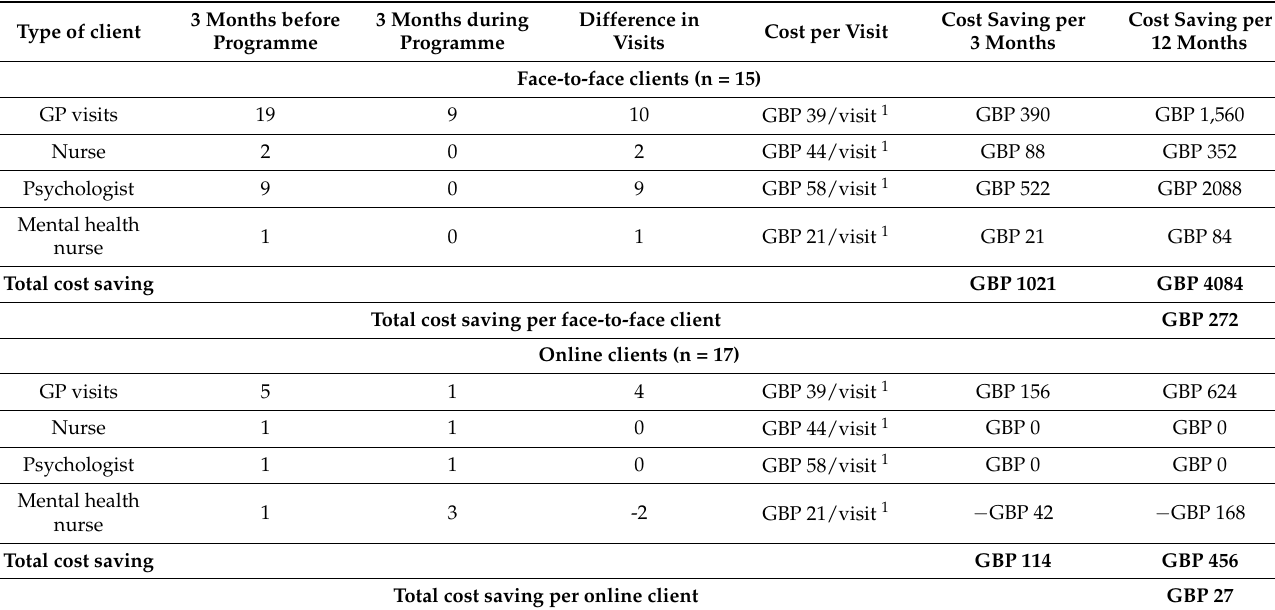
Table 9. Health service resource use for face-to-face and online